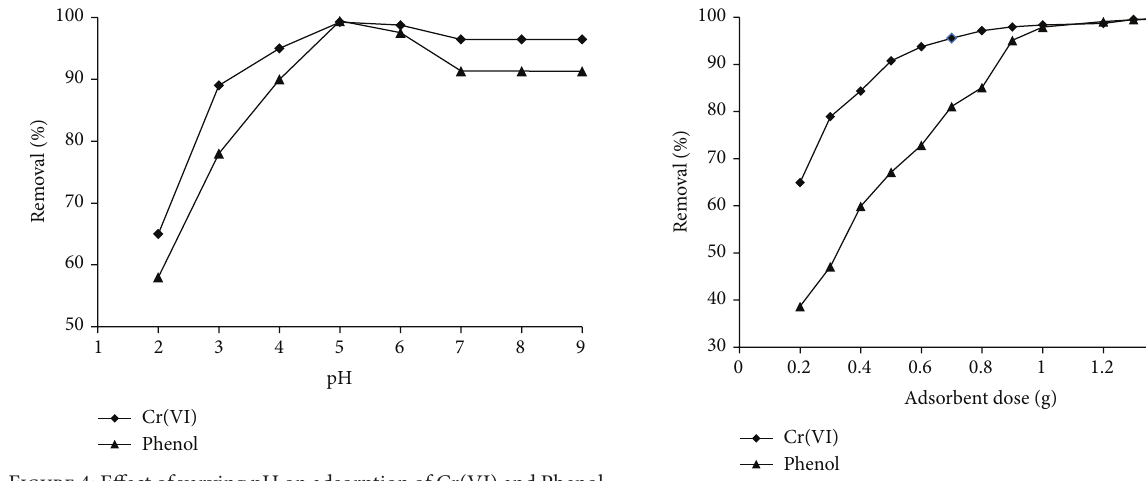
Figure 5: Effect of quantity of Fe treated rice husk on adsorption of Cr(VI) and